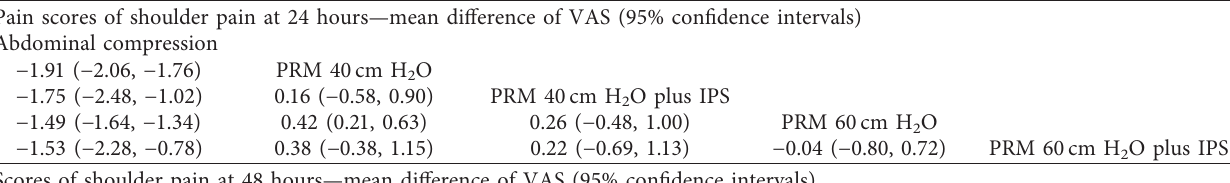
Table 1: Network-estimated effect measures of intervention on shoulder pain.